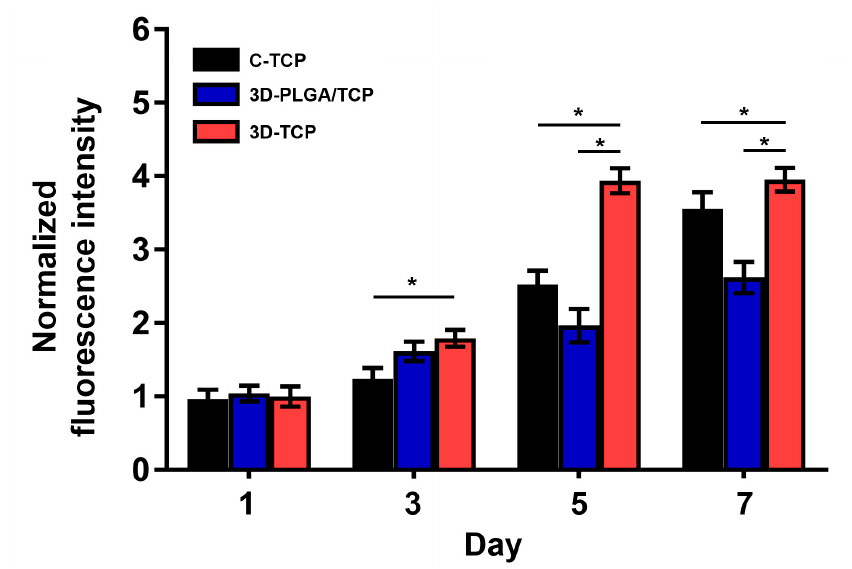
Figure 6. hDPSCs proliferation on C-TCP, 3D-PLGA / TCP, and 3D-TCP sca ff olds. AlamarBlue assays indicated that all sca ff olds significantly promoted the proliferation of hDPSCs (* p < 0.050).